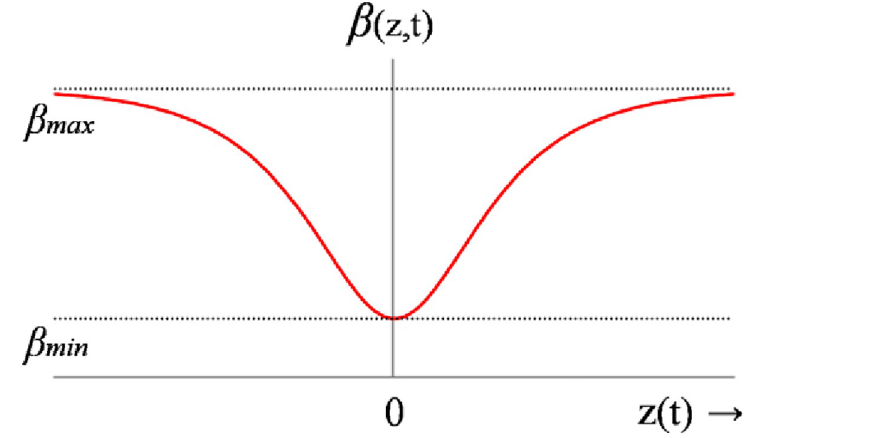
Fig 3. The waveform of hyperbolic-secant-function.